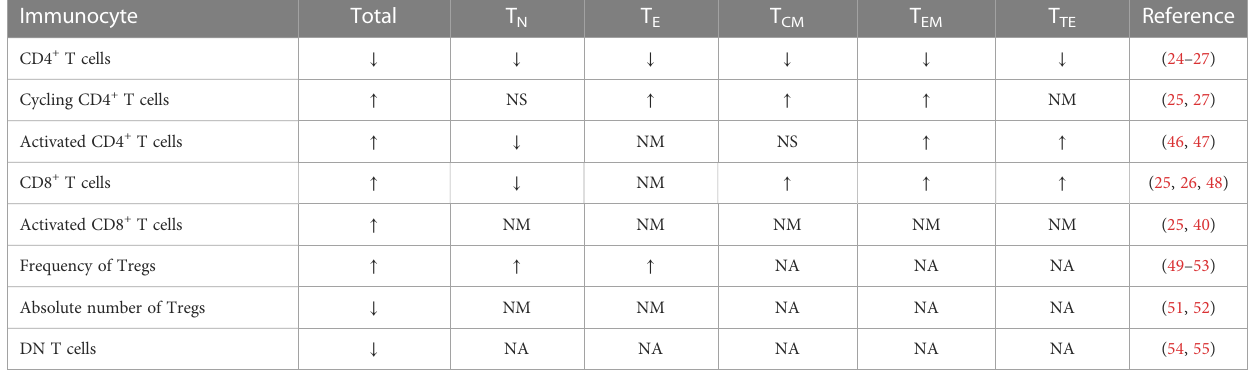
TABLE 1 Alterations in the quantity of immunocytes in HIV/AIDS patients with incomplete immune reconstitution.